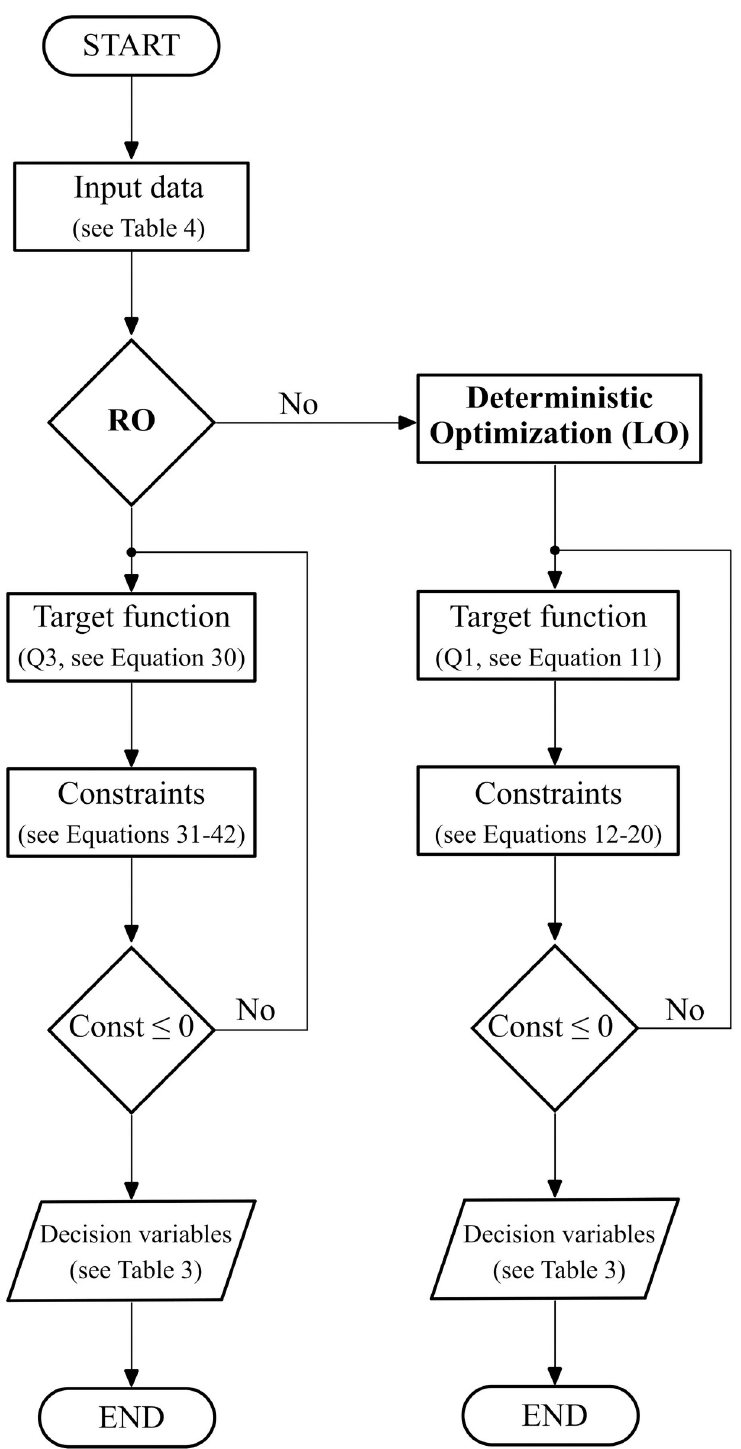
Fig 4. Flow chart of the optimization